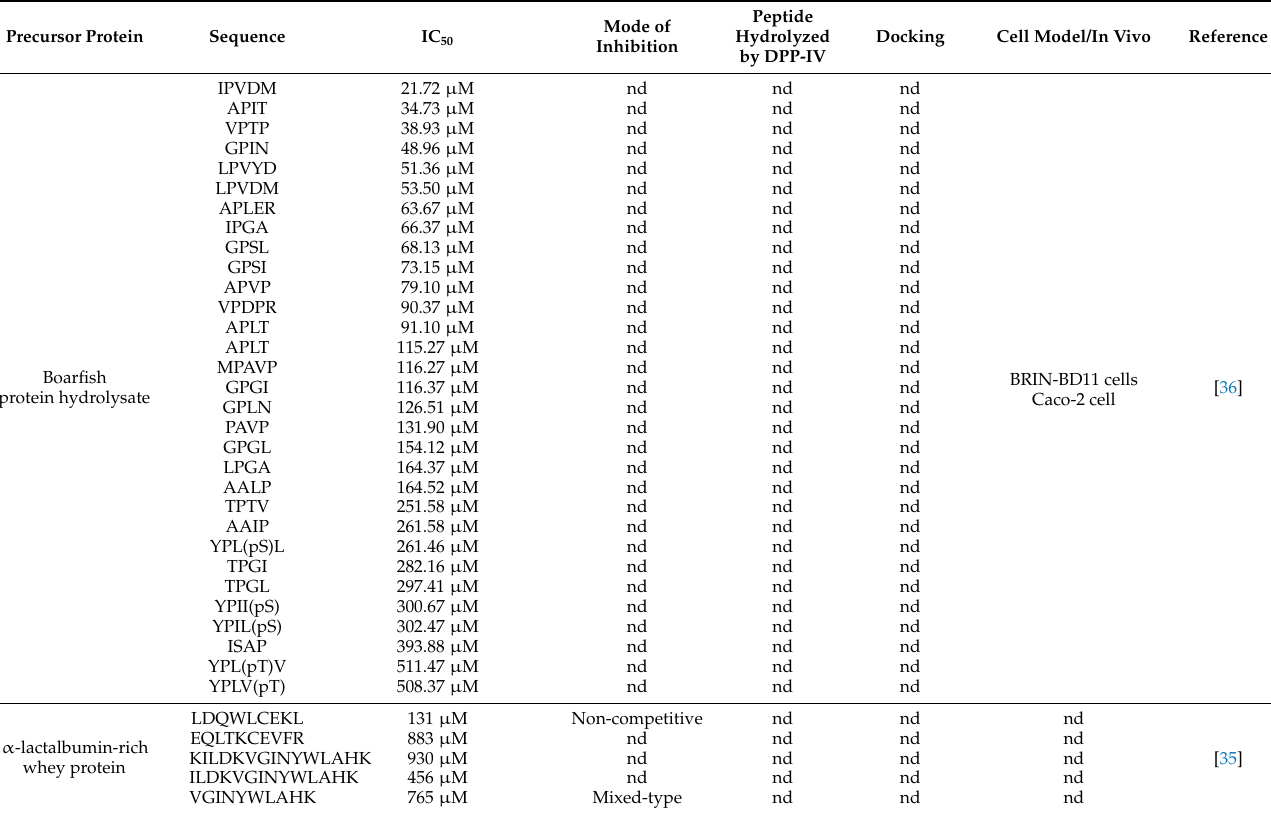
Table 1. Summary of recent publications concerning DPP-IV inhibitory peptides